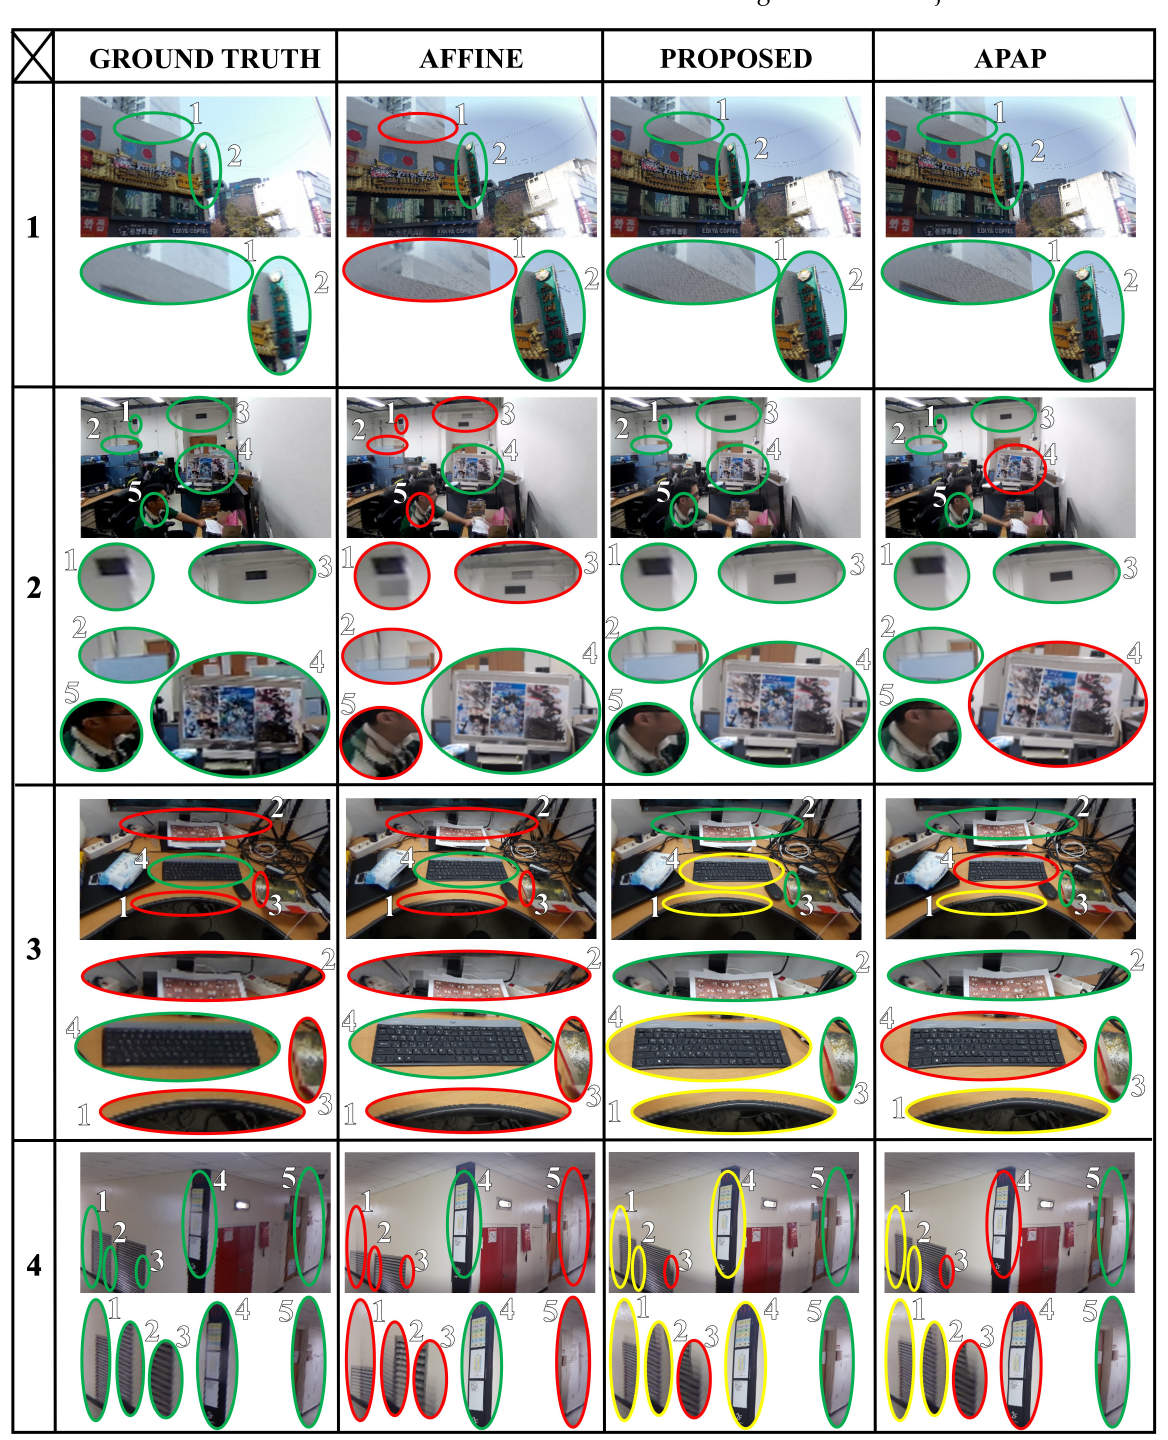
Figure 12. Visual comparison of the resulting HROI-TI between proposed image alignment with affine and APAP. Red, yellow, and green outline respectively represent subjective “bad”, “medium”, and “good” evaluation of the alignment and the object shape quality. Overall, the AFFINE method could preserve the object shape in the central region but suffered from misalignment on the boundary. The APAP method could align the boundary better but suffered from distortion in the central region. The PROPOSED method could agree between the alignment error found in AFFINE and the distortion error found in APAP. We used the ROI-TI as the GROUND TRUTH. Zoom in the image to see the resolution difference between the ROI tangent image (ROI-TI) with the affine, the APAP, and the